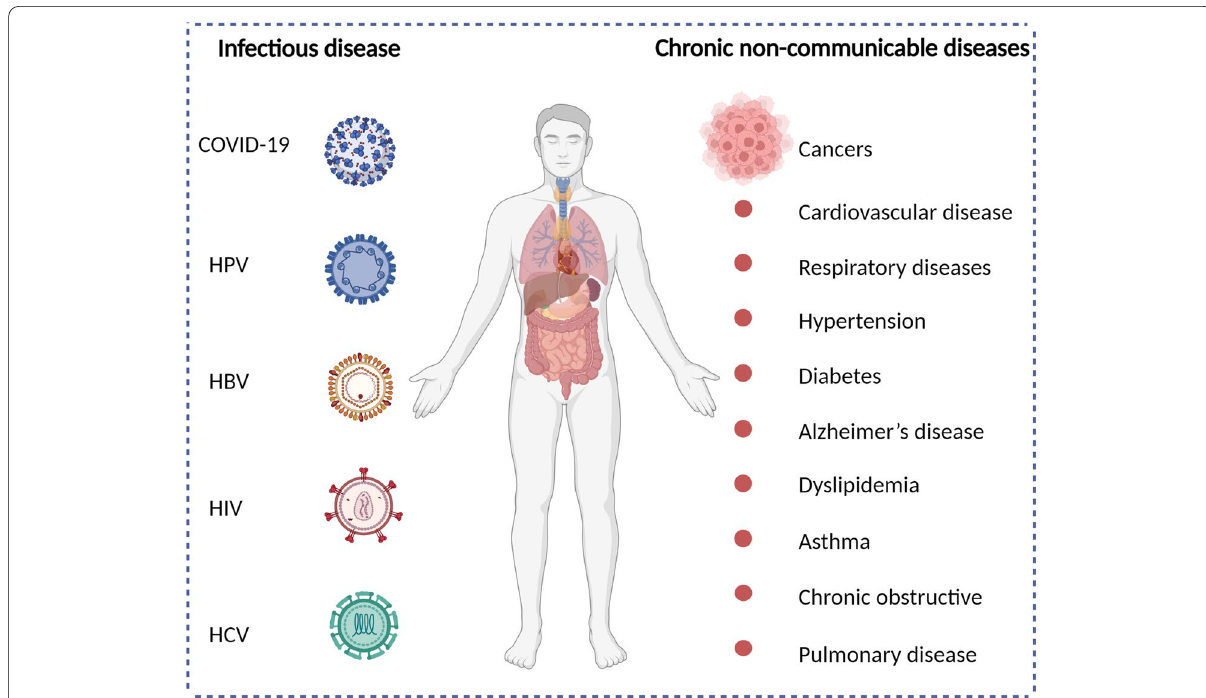
Fig. 1 A summary of infectious disease and chronic non-communicable